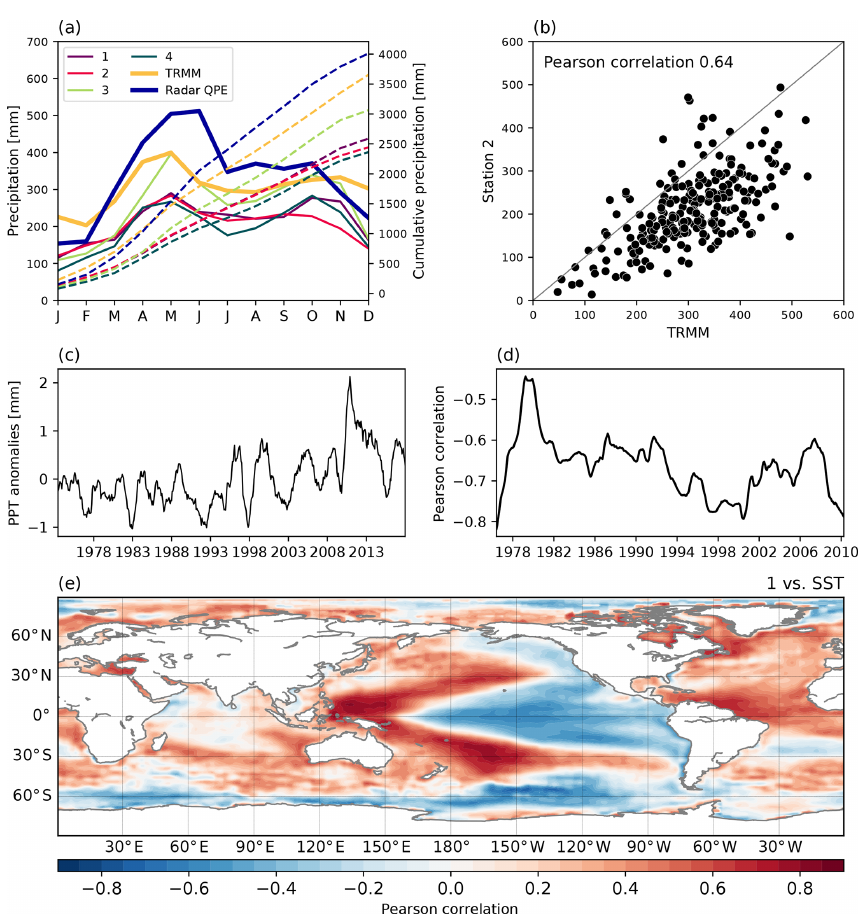
Figure 4. (a) Mean annual cycle of precipitation near Salgar from IDEAM rain gauges and TRMM 3B42 product (thick yellow line) using data from 1998 to 2018. The panel also shows the 5-year average monthly QPE rainfall from 2014 to 2018. (b) Scatter plot between monthly TRMM records and one of the in situ gauges, showing the Pearson correlation between both series (0.64). (c) Precipitation anomalies over La Liboriana, after filtering all variability with periods equal to or shorter than 13 months. (d) The 10-year windowed moving correlation between the Multivariate ENSO Index (MEI) and in situ precipitation. (e) Spatial distribution of the correlation between filtered SST and in situ